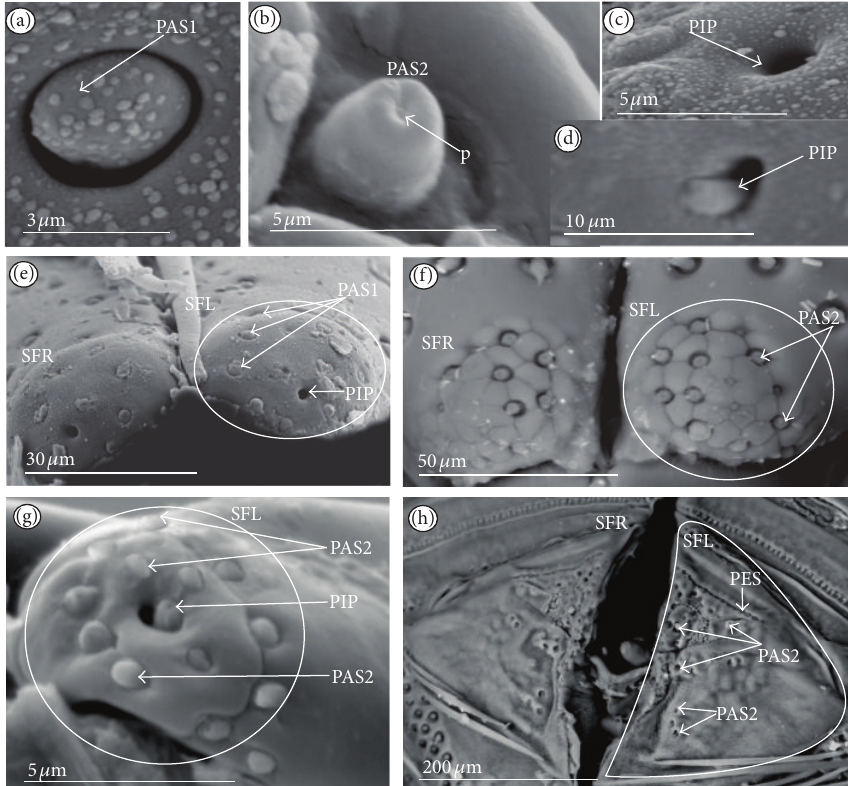
Figure 5: Types and arrangements of the labial apical sensilla of the Nepomorpha. (a) PAS1 papilla-like sensillum, flattened. (b) PAS2 papilla- like sensillum, rounded. (c) PIP peg-in-pit sensillum, only the pit is visible. (d) Peg-in-pit sensillum, the peg is visible. (e) PAS1 sensilla are circularly placed on the smooth, rounded labial tip with a slightly lateral position of the PIP. These are arranged symmetrically on the right (SFR) and left (SFL) sensory field. (f) PAS2 sensilla are circularly placed on the folded labial tip. The PIP are invisible. They are arranged symmetrically on the right (SFR) and left (SFL) sensory fields. (g) PAS2 sensilla are circularly placed on the labial tip with the central position of the PIP sensillum; the left (SFL) sensory field is shown. (h) PAS2 sensilla are irregularly placed on the labial tip. These sensilla are arranged symmetrically on the right (SFR) and left (SFL) sensory fields. PES form a short row; RBS ribbon-like sensilla (mechanosensilla) are not